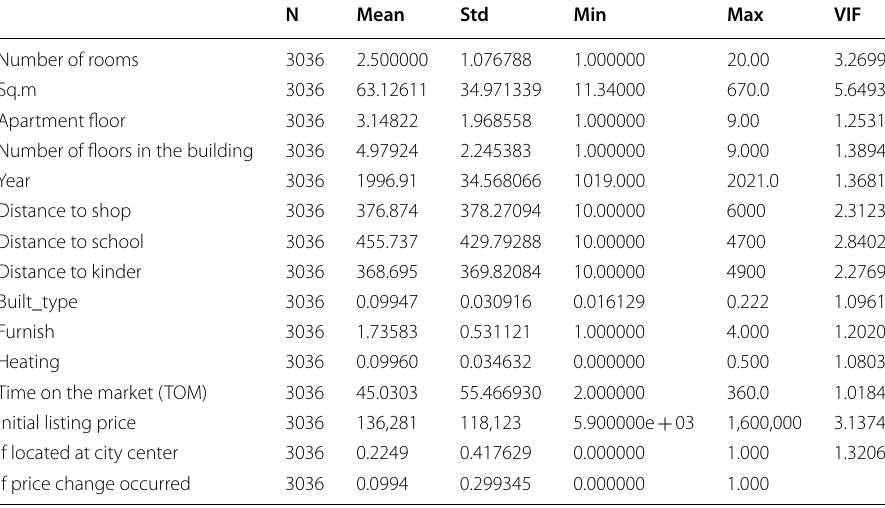
Table 5 Sample descriptive statistics for month August sell